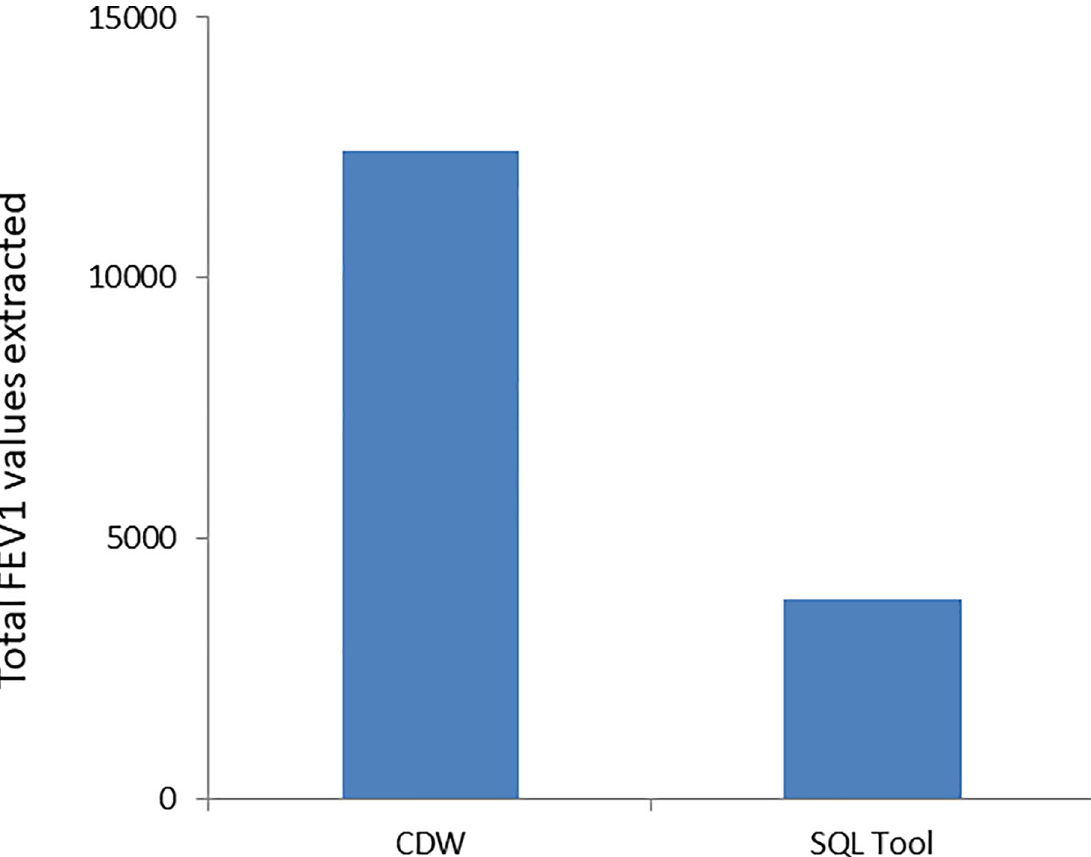
Fig 2. Numeric FEV1 extraction yield including SQL tool. The SQL tool increased FEV1 yield by 3849 (24%) compared with CDW alone.